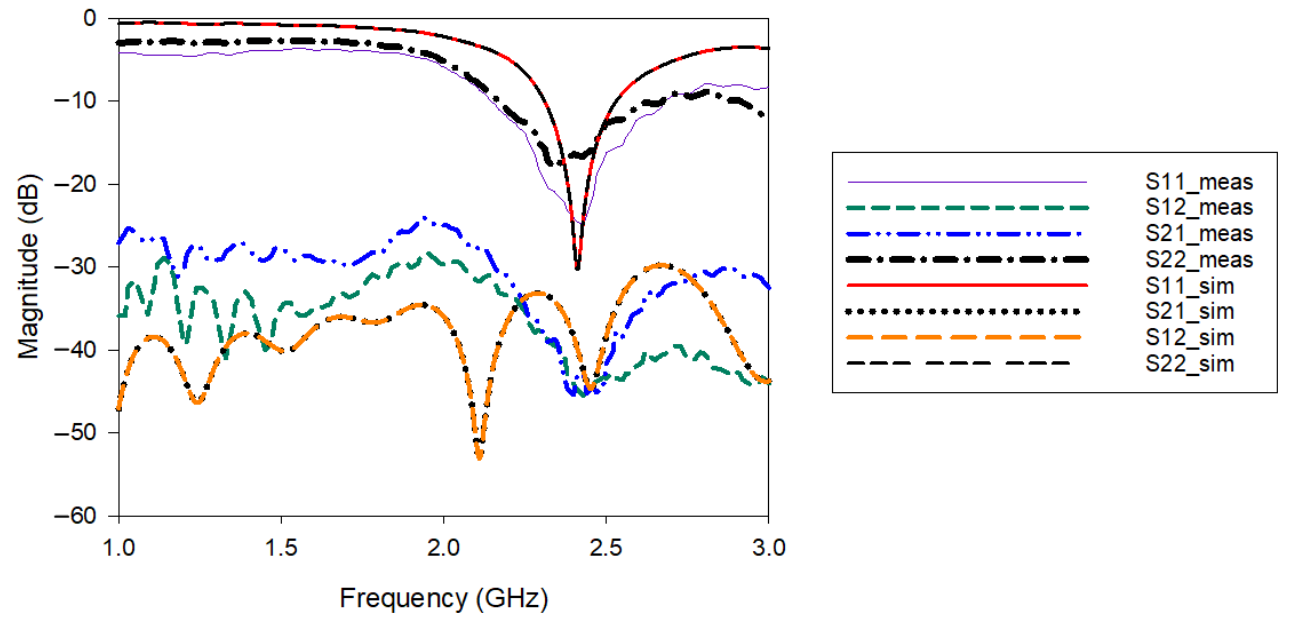
Figure 12. Simulated and measured S-parameters of the MIMO-RIS-EBG.